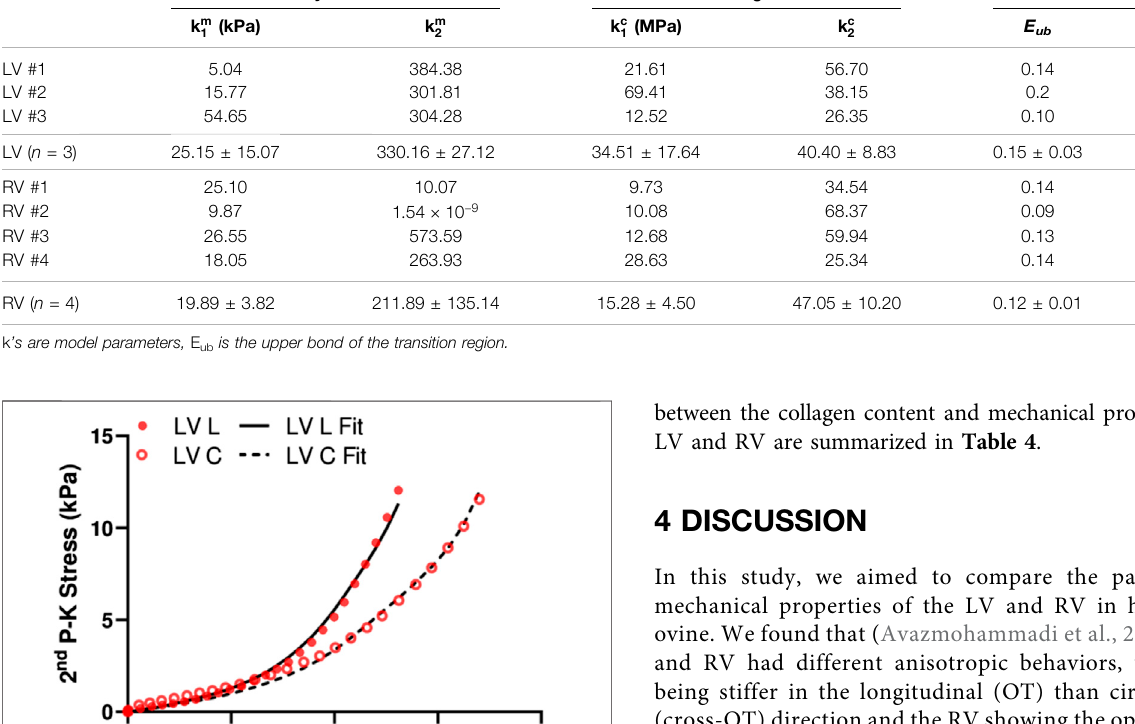
TABLE 3 | Structurally informed model fi tting results. Average data are presented as mean ± SEM. Myo fi ber Collagen RMS